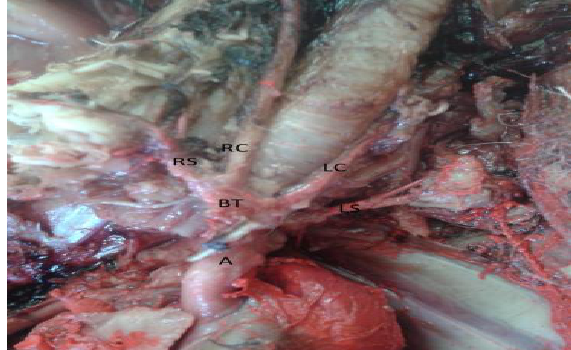
Figure, 2: Aortic arch insitue in rabbit showing: (A) aortic arch (BT) Brachiocephalic trunk (LS) left subclavian artery (LC) Left common carotid artery (RC) right common carotid artery (RS) Right subclavian artery.